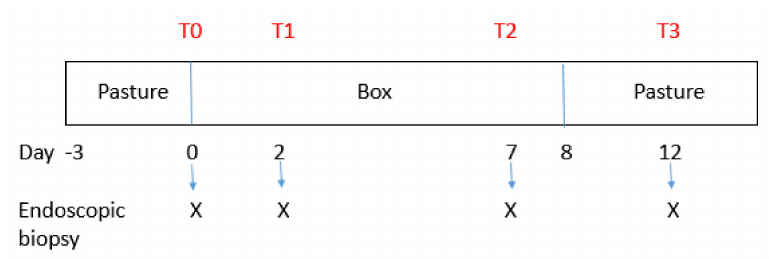
Figure 2. Timeline flow chart of